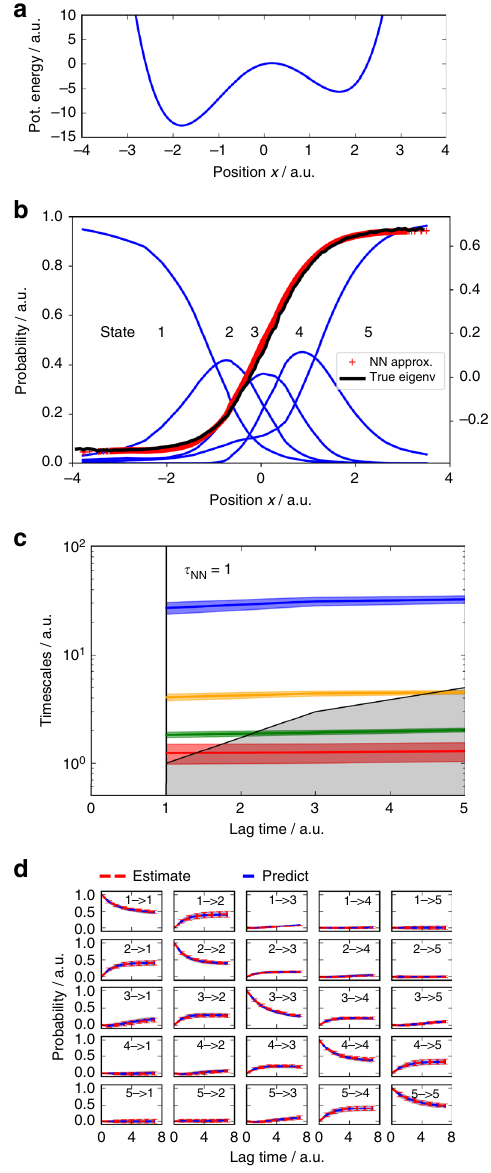
Fig. 2 Approximation of the slow transition in a bistable potential. a Potential energy function U ( x ) = x 4 − 6 x 2 + 2 x . b Eigenvector of the slowest process calculated by direct numerical approximation (black) and approximated by a VAMPnet with fi ve output nodes (red). Activation of the fi ve Softmax output nodes de fi ne the state membership probabilities (blue). c Relaxation timescales computed from the Koopman model using the VAMPnet transformation. d Chapman – Kolmogorov test comparing long- time predictions of the Koopman model estimated at τ = 1 and estimates at longer lag times. c , d report 95% con fi dence interval error bars over 100 training runs intersecting transition region (Supplementary Fig. 1b). The network excellently approximates the Koopman eigenfunction of the folding process, as apparent from the comparison of the values of the network eigenfunction computed by Eq. (15) with the eigenvector computed from a high-resolution MSM built on the r coordinate (Supplementary Fig. 1b). This demonstrates that the network can learn the nonlinear reaction coordinate mapping r ¼ x j j based only on maximizing the variational score (Eq. 6). Furthermore, the implied timescales and the CK test indicate that NATURE COMMUNICATIONS | (2018) 9:5 | DOI: 10.1038/s41467-017-02388-1 |